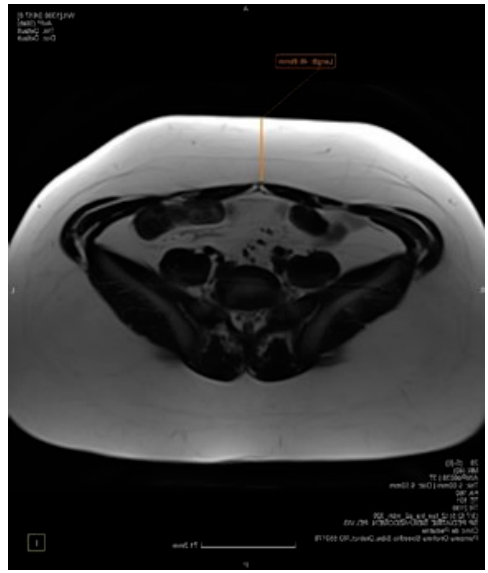
Figure 4. MRI T2 HASTE, T5 transversal section showing the measurement of abdominal wall sub- cutaneous adipose tissue thickness (46.85 mm). Prepared by the authors. Courtesy of the Pediatric Clinical Hospital Sibiu, Lucian Blaga University of Sibiu.